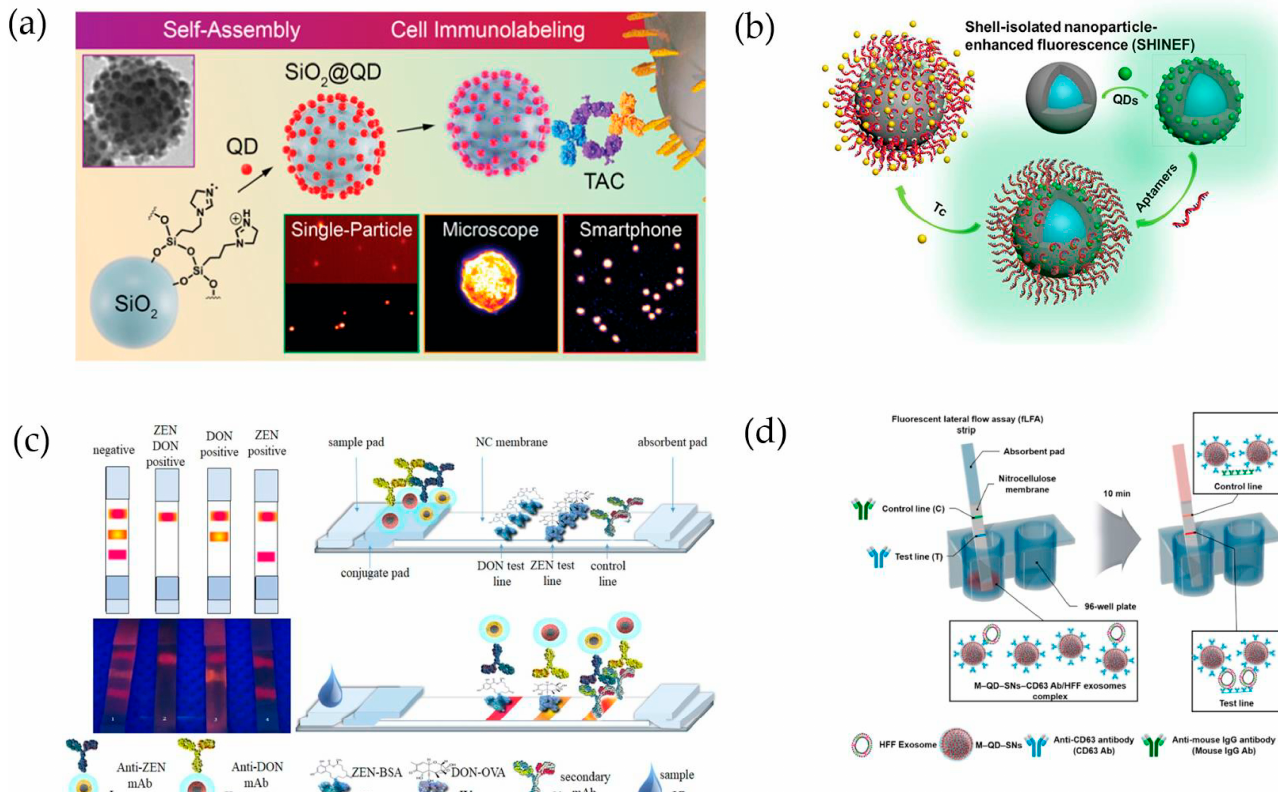
Figure 3. ( a ) QD-introduced self-assembly procedure into silica NPs (SiO 2 @QD-TACs) and cell immunolabeling. [53] ( b ) QD-embedded silica-coated Ag NPs (Ag@SiO 2 /QDs) and attached aptamer (Ag@SiO 2 /QDs-Apt). Tc detection using shell-isolated NP-enhanced fluorescence (SHINEF) [54]. ( c ) Detection of zealralenone (ZEN) and deoxynivalenol (DON) using LFIA with QD@SiO 2 [55]. ( d ) Detection of human foreskin fibroblast exosomes using fLFA with M-QD-SNs [56].